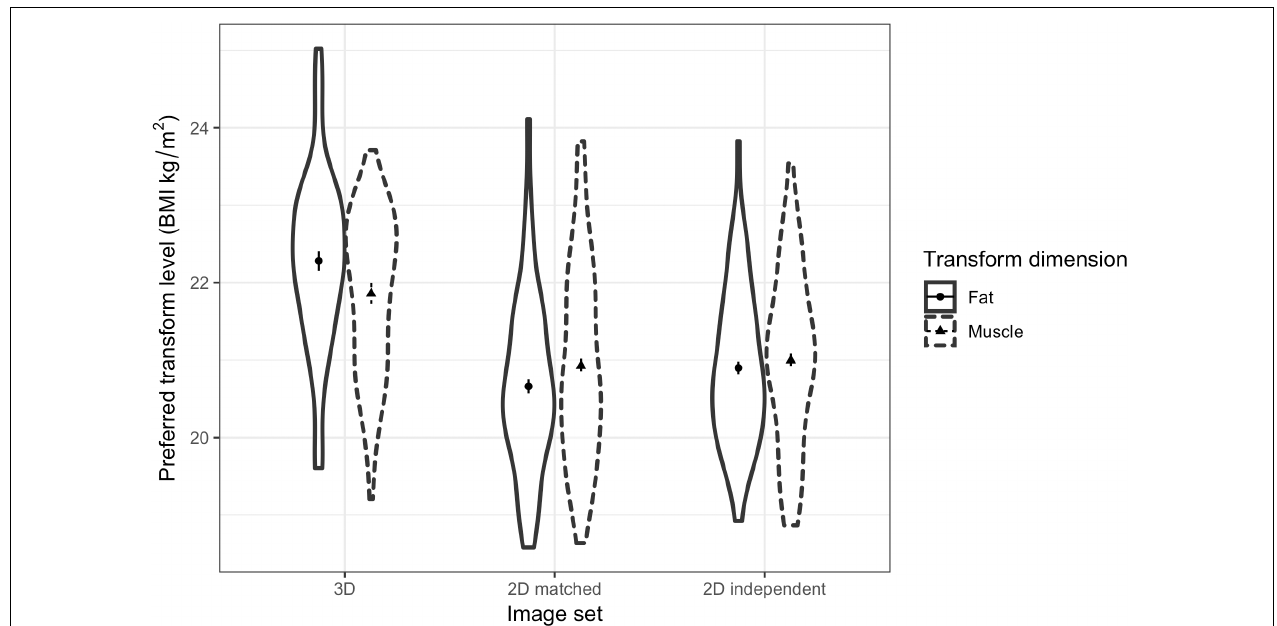
FIGURE 7 | Violin plots showing the distribution of female students’ preferences for the facial correlates of fat mass and muscle mass in men. The vertical axis represents the associated BMI of the most preferred faces chosen by the students in short-term and long-term relationship contexts. The error bars represent the standard errors and the symbols indicate means.